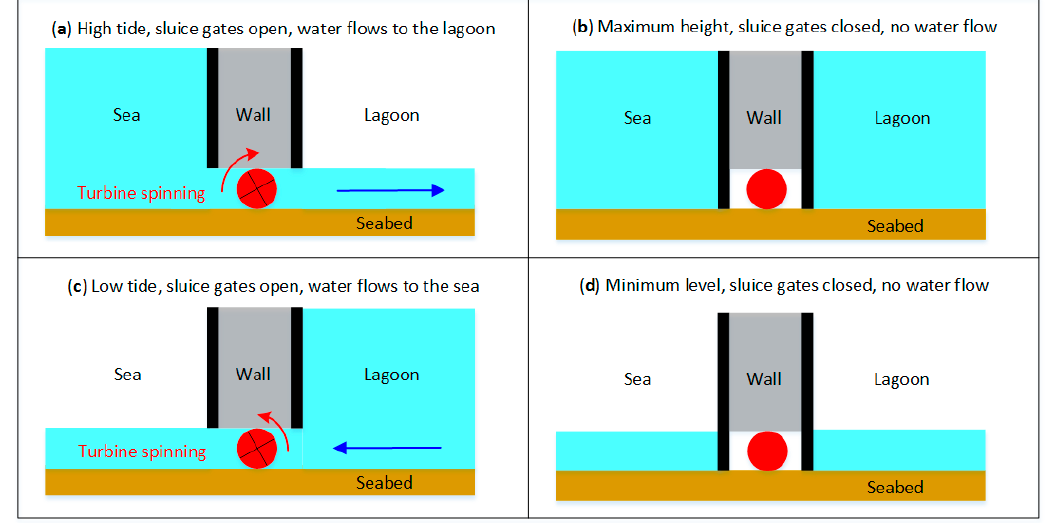
Figure 9. Illustration of steps in a single-basin tidal lagoon operation: the turbines are installed within the lagoon walls, and water flow is regulated by means of sluice gates. ( a ) flow tide generation; ( b ) no generation at high tide; ( c ) ebb tide generation; ( d ) no generation at low